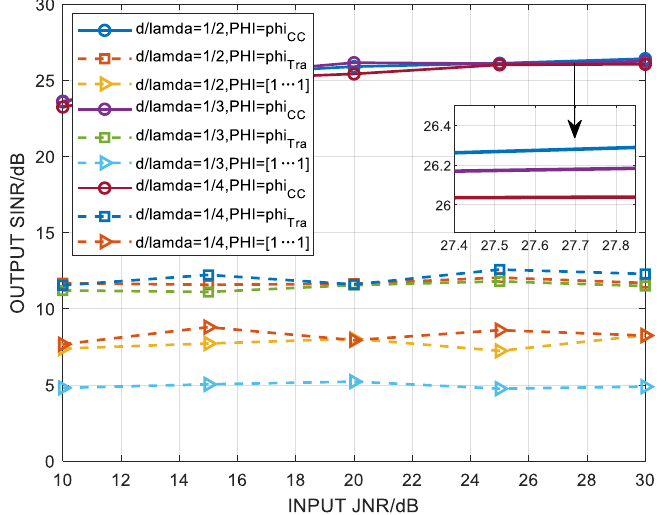
Figure 7. Comparison of anti-jamming performance of different algorithms based on metamaterial